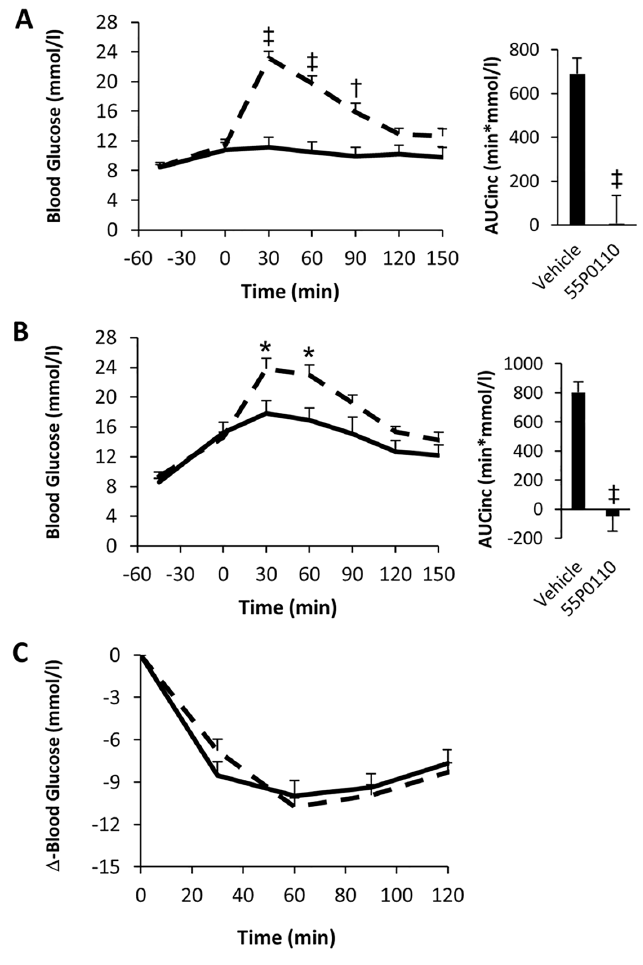
Fig 5. A single dose of 55P0110 improves glucose tolerance but not insulin sensitivity in diabetic mice. Effect of feeding 180 mg/kg 55P0110 to 9 weeks-old ( A ) or 90 mg/kg 55P0110 to 12 weeks-old ( B ) fasted male db/db mice at -45 min before an oral glucose tolerance test (2 g/kg). Glucose curve and incremental area under the glucose curve (AUCinc) are shown. ( C ) Effect of feeding 90 mg/kg 55P0110 at -45 min on an insulin tolerance test (1.5 U/kg) in 14 weeks-old male db/db mice. 55P0110, full lines; vehicle, broken lines; means ± SEM; n = 9 – 10 each; * p < 0.05; † p < 0.01; ‡ p < 0.001 vs.